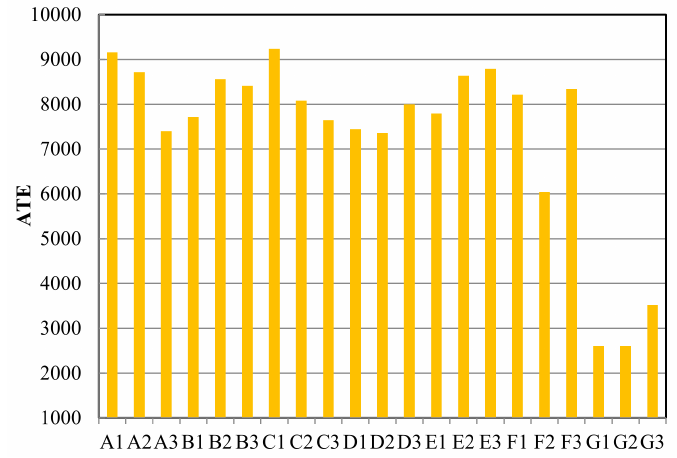
Figure 5. Acute toxicity estimates of FCC spent catalyst samples from different units.